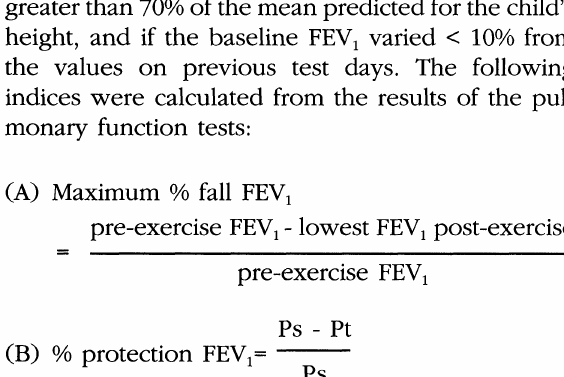
Table 2. Percentage of protection from EIA Patient